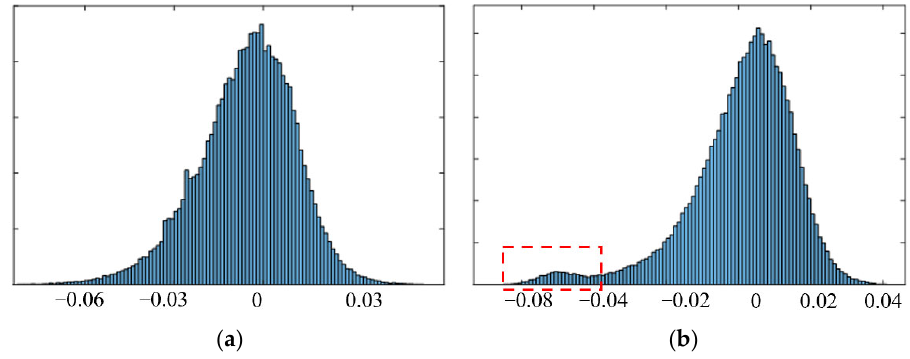
Figure 8. The histogram of the deformation results for ( a ) the proposed method and ( b ) SBAS.